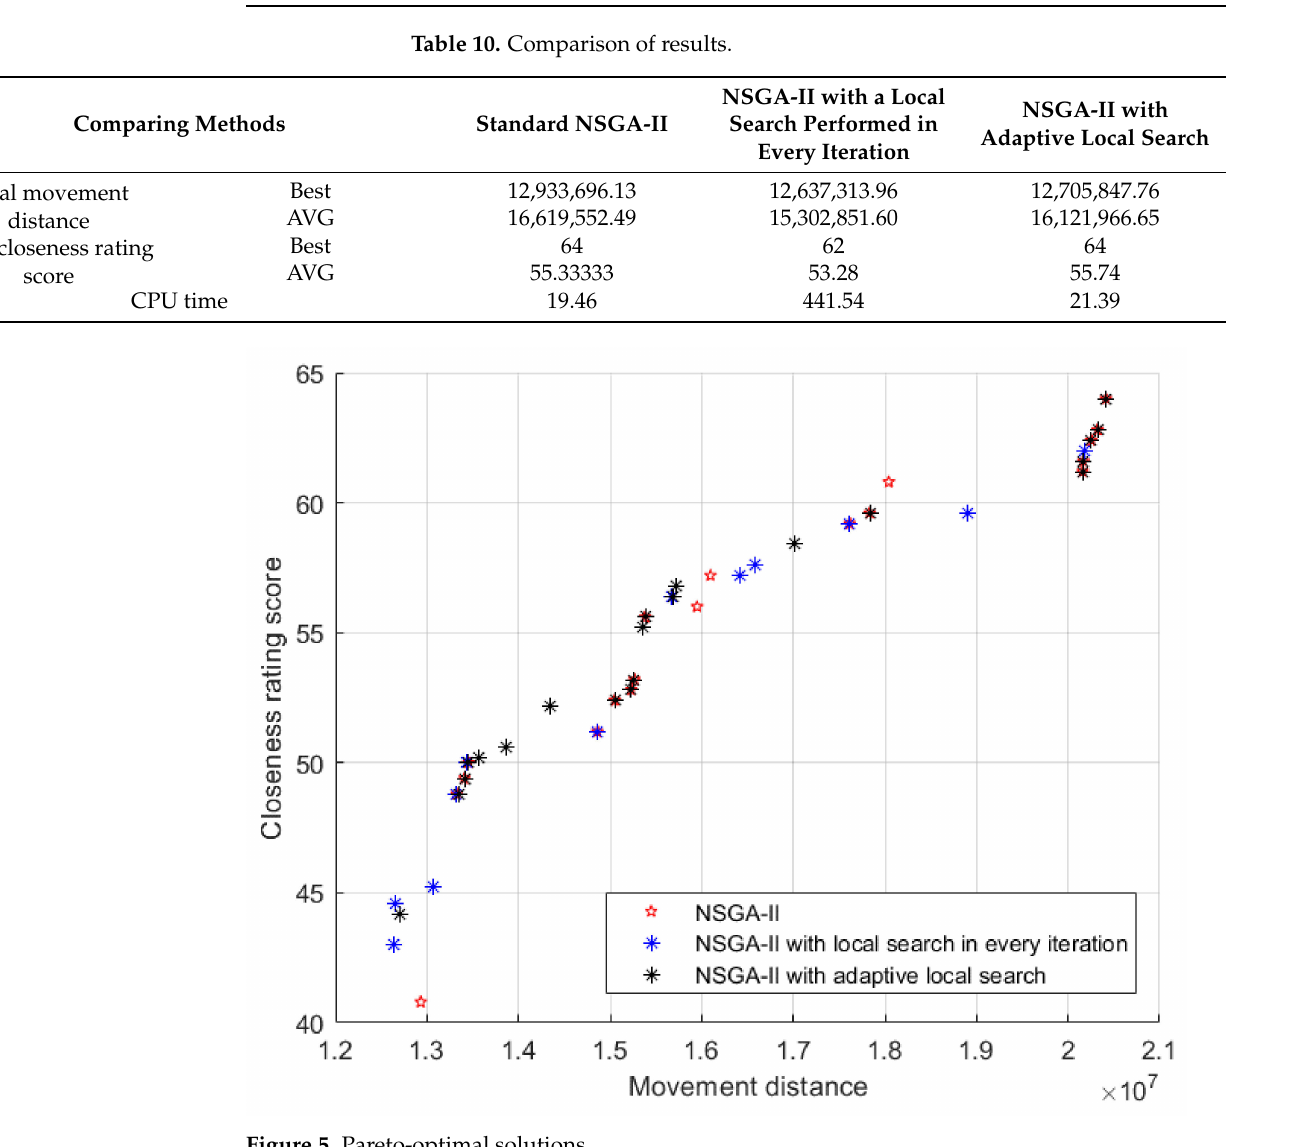
Figure 5. Pareto-optimal